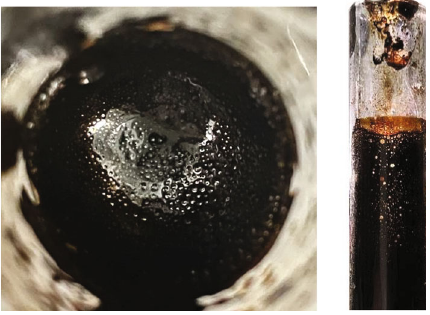
Figure 8: Foam form of produced oil.